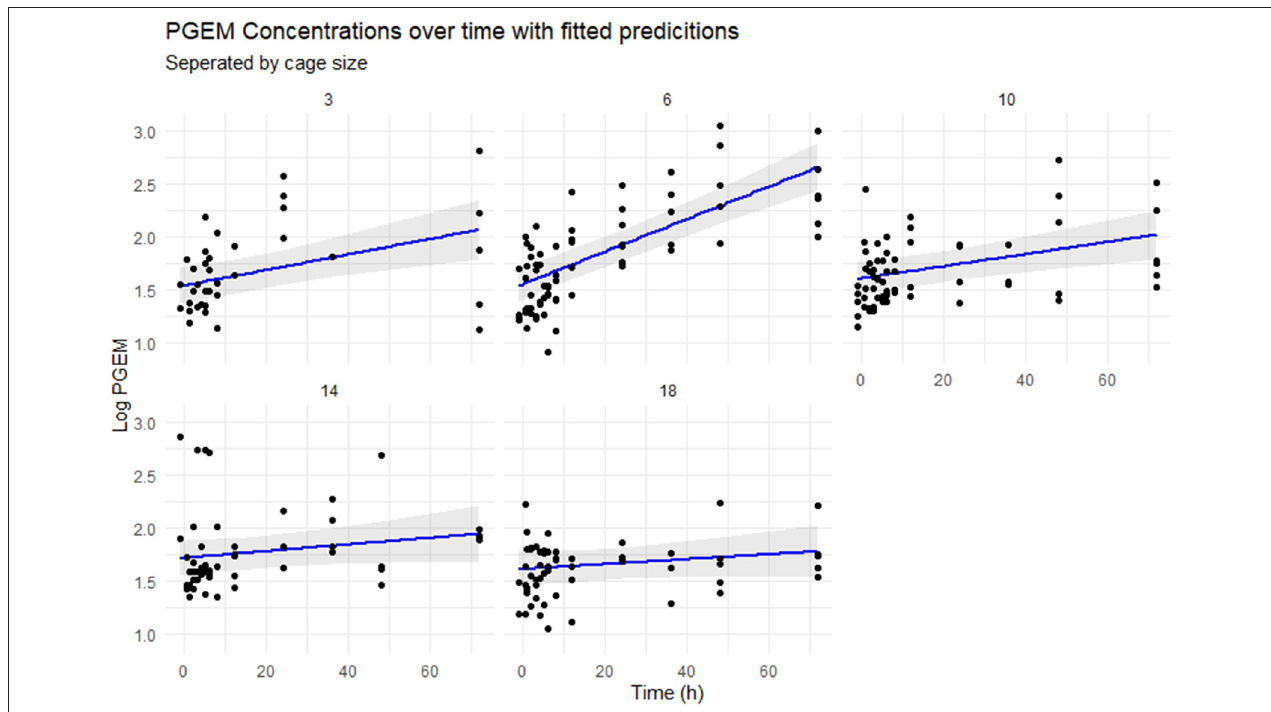
FIGURE 4 | Scatterplot of the logarithmically transformed PGEM concentrations over time, separated by cage size. The blue line represents the concentrations predicted by the mixed effect model, with 95% CIs in gray.